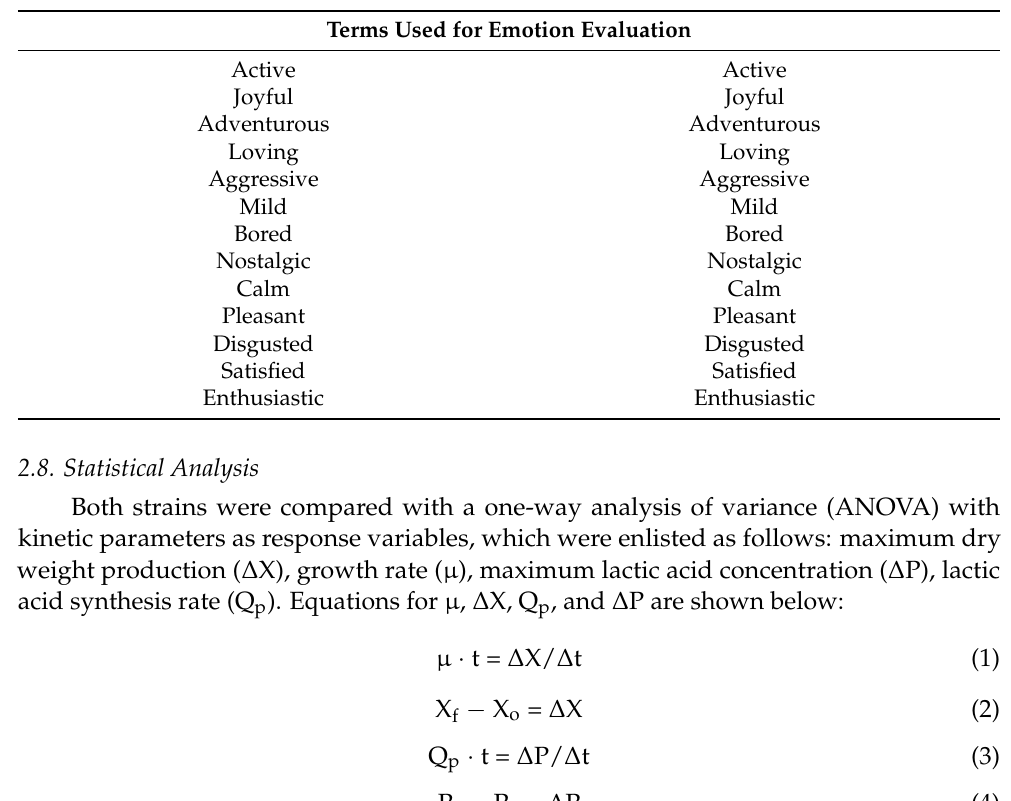
Table 1. EsSense25 profile emotion terms